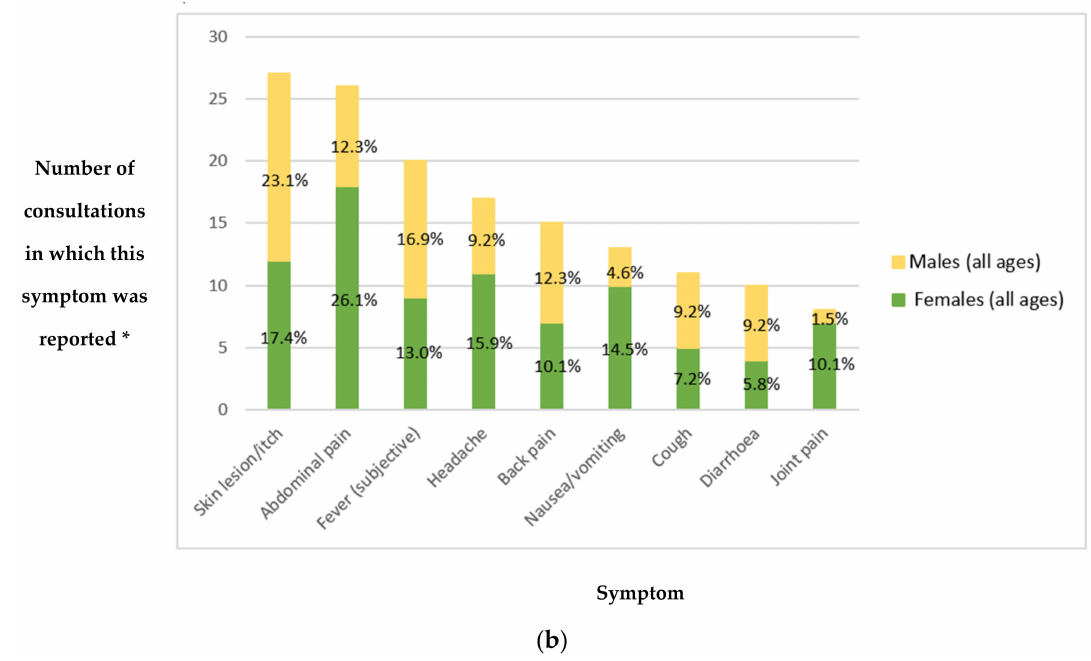
Figure 2. ( a ) Most common symptoms reported by clinic attendees, categorised by age; ( b ) most common symptoms reported by clinic attendees, categorised by sex. * Percentages denote proportion of consultations (categorised by child/adult or female/male) in which this symptom was reported. For example, skin lesion/itch was reported in 27.3% (18/66) of child consultations compared to 13.2% (9/68) of adult consultations, and in 17.4% (12/69) of female consultations compared to 23.1% (15/65) of male